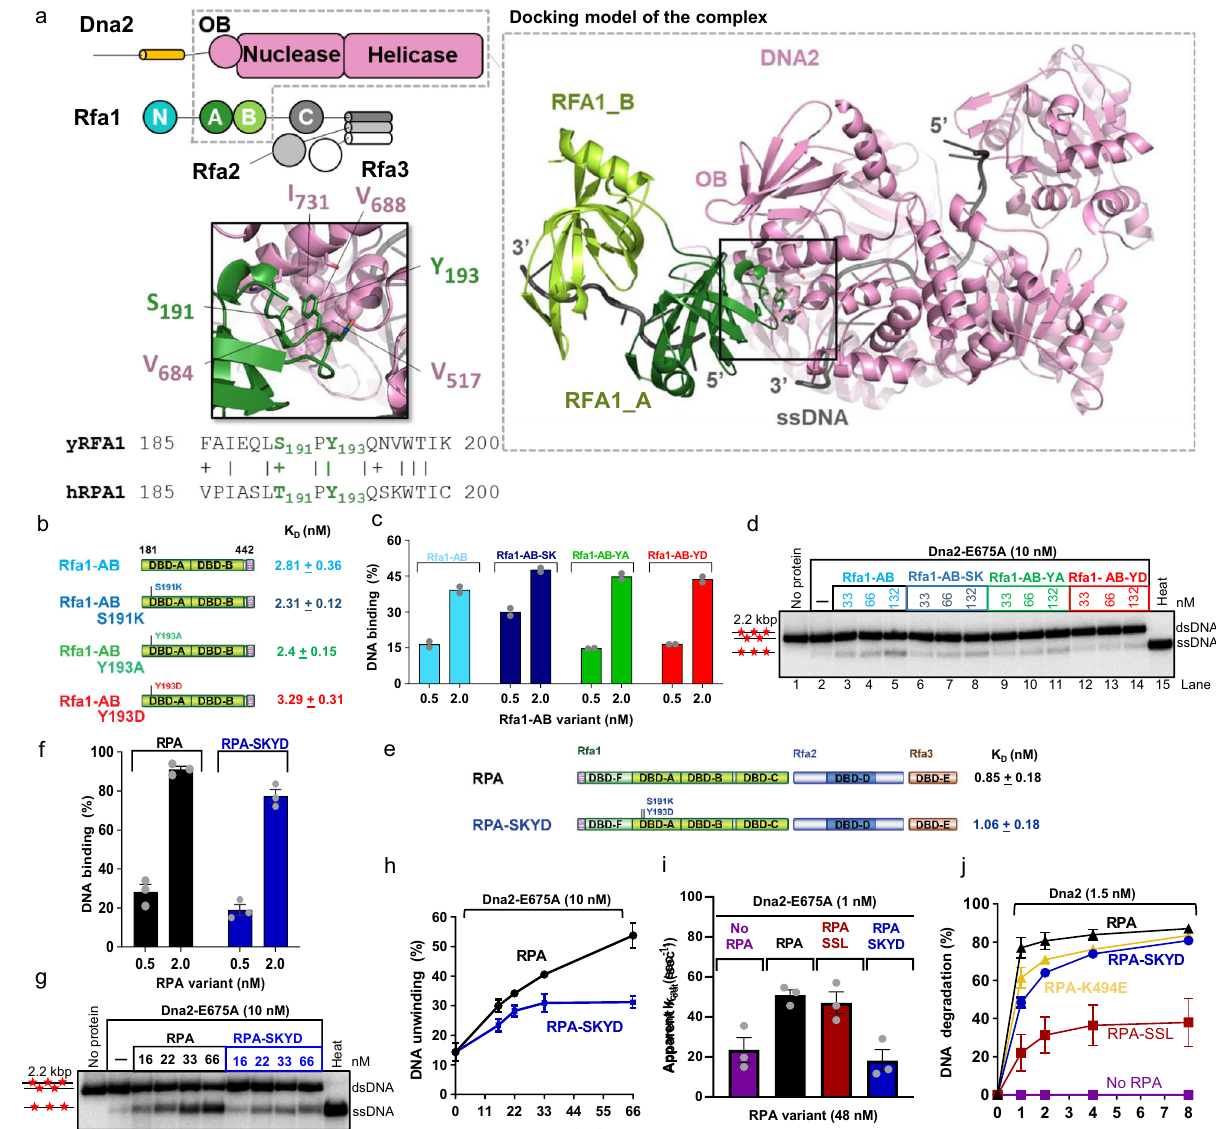
Fig. 6 The DBD-A and DBD-B domains of Rfa1 speci fi cally promote the Dna2 helicase. a A schematic representation of the domain organization in Dna2 and RPA, highlighting with a dashed gray box the domains used as inputs of the free docking simulation. Right, most likely structural model obtained after free docking with the InterEvDock2 server. Dna2 nuclease-helicase domain and the AB module of Rfa1 are represented in pink and green, respectively, ssDNA is in dark gray. Lower left panel focuses on the interaction region of Rfa1 (in green) with Dna2 (in pink), highlighting the conserved residues S191 and Y193 of Rfa1. Y193 is predicted to anchor in an apolar pocket exposed at the surface of Dna2 formed by V517, V684, V688 and I731. Bottom, pairwise sequence alignment between S. cerevisiae Rfa1 and human RPA1 sequences in the region 185 – 200 highlights the conservation of the Y193 residue. b A schematic representation of the primary structure of wild type Rfa1-AB and point mutants. Rfa1-AB is again shown as reference. K D, concentration of the respective Rfa1-AB variant resulting in 50% binding to ssDNA (93 nt, 0.1 nM, in molecules) such as shown in Supplementary Fig. 6c. Error, range; n = 2. c Quantitation of Rfa1-AB variants binding to ssDNA (93 nt, 0.1 nM, in molecules) as shown in Supplementary Fig. 6c. Rfa1-AB is replotted as in Fig. 3e for reference. Bars show range; n = 2. d Representative experiments showing unwinding of 2.2-kbp-long dsDNA (0.1 nM, in molecules) by Dna2-E675A in the presence of Rfa1-AB variants. Red asterisks indicate random radioactive labels on the DNA. The experiment was performed three times with similar results. e Primary structure of the RPA-SKYD mutant. Wild type RPA is again shown as a reference. K D, concentration of the respective Rfa1-AB variant resulting in 50% binding to ssDNA (0.1 nM, in molecules, 93-nt-long) such as shown in Supplementary Fig. 6f. Error, SEM; n = 3. f DNA binding by RPA-SKYD to ssDNA (93 nt, 0.1 nM, in molecules) as shown in Supplementary Figs. 3c and 6f. RPA is replotted as in Fig. 3b for reference. Error bars, SEM; n = 3. g Representative experiments showing unwinding of 2.2-kbp-long dsDNA (0.1 nM, in molecules) by Dna2-E675A in the presence of wild type RPA or RPA- SKYD. h Quanti fi cation of helicase assays such as shown in panel g . Error bars, SEM; n = 3. i Apparent ATP turnover number and its dependence on various RPA variants (48 nM) in the presence of single-stranded DNA (50 nt, 1 μ M, in nucleotides). The reactions contained Dna2 E675A (1 nM) and ATP (1 mM). Error bars, SEM, n = 3. j Quanti fi cation of nuclease assays such as shown in Supplementary Fig. 6g showing kinetics of degradation of 2.2-knt-long ssDNA (0.3 nM) by Dna2 in the presence of RPA variants (50 nM) and with 100 mM KCl. Error bars, SEM; n = 3.